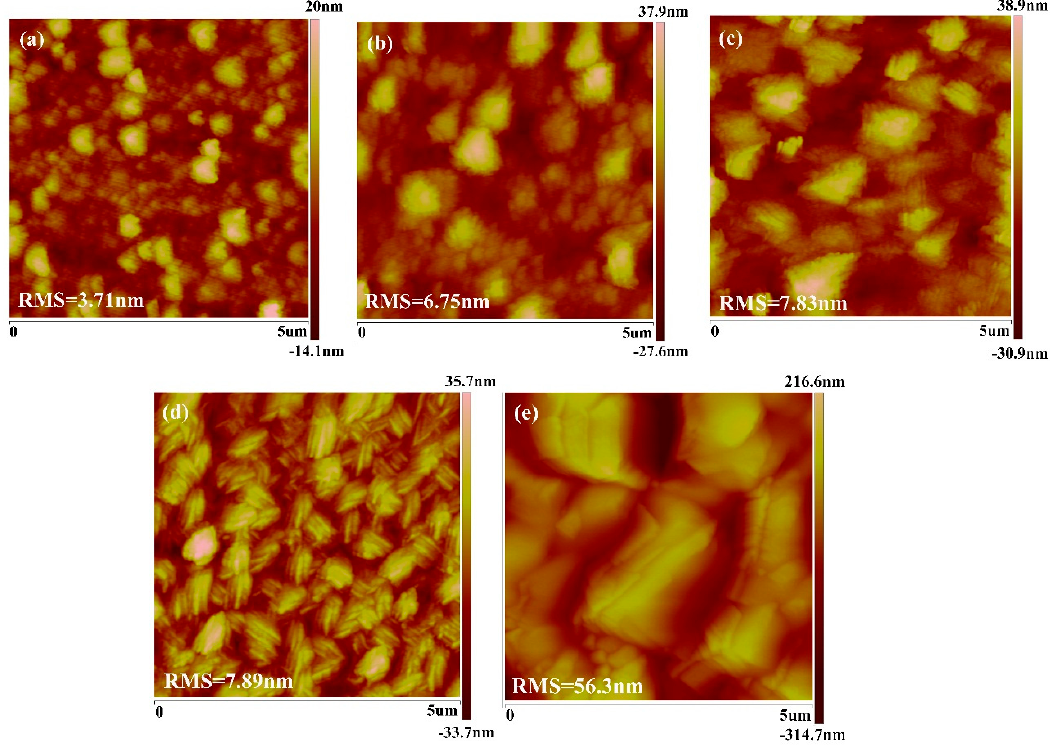
Figure 3. AFM images (5 μ m × 5 μ m) of β -Ga 2 O 3 films grown with various VI/III ratios: ( a ) 66.9 × 10 3 ; ( b ) 22.3 × 10 3 ; ( c ) 11.2 × 10 3 ; ( d ) 7.4 × 10 3 ; ( e ) 5.6 × 10 3 .